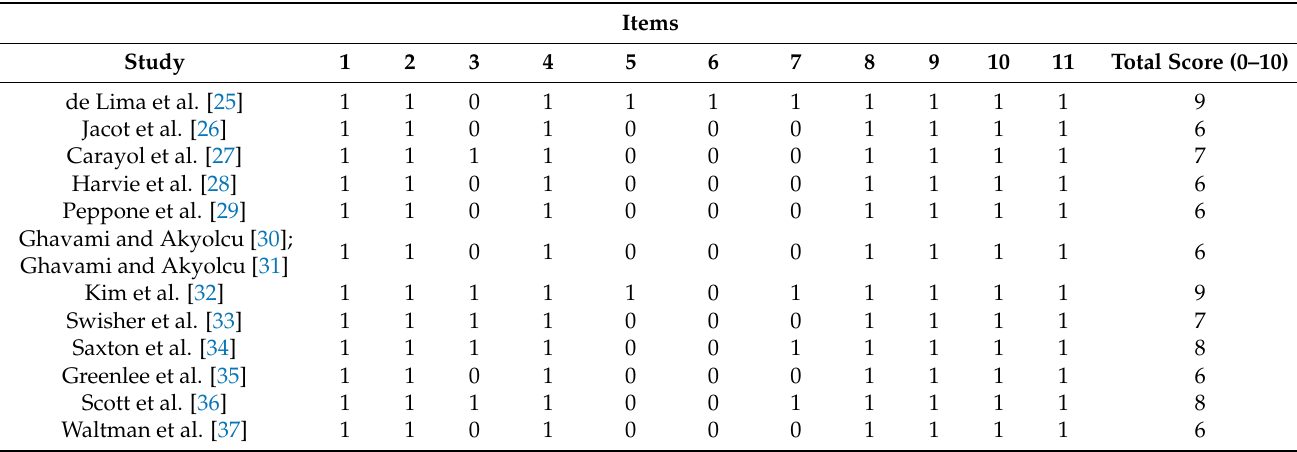
Table 3. Methodological quality of included